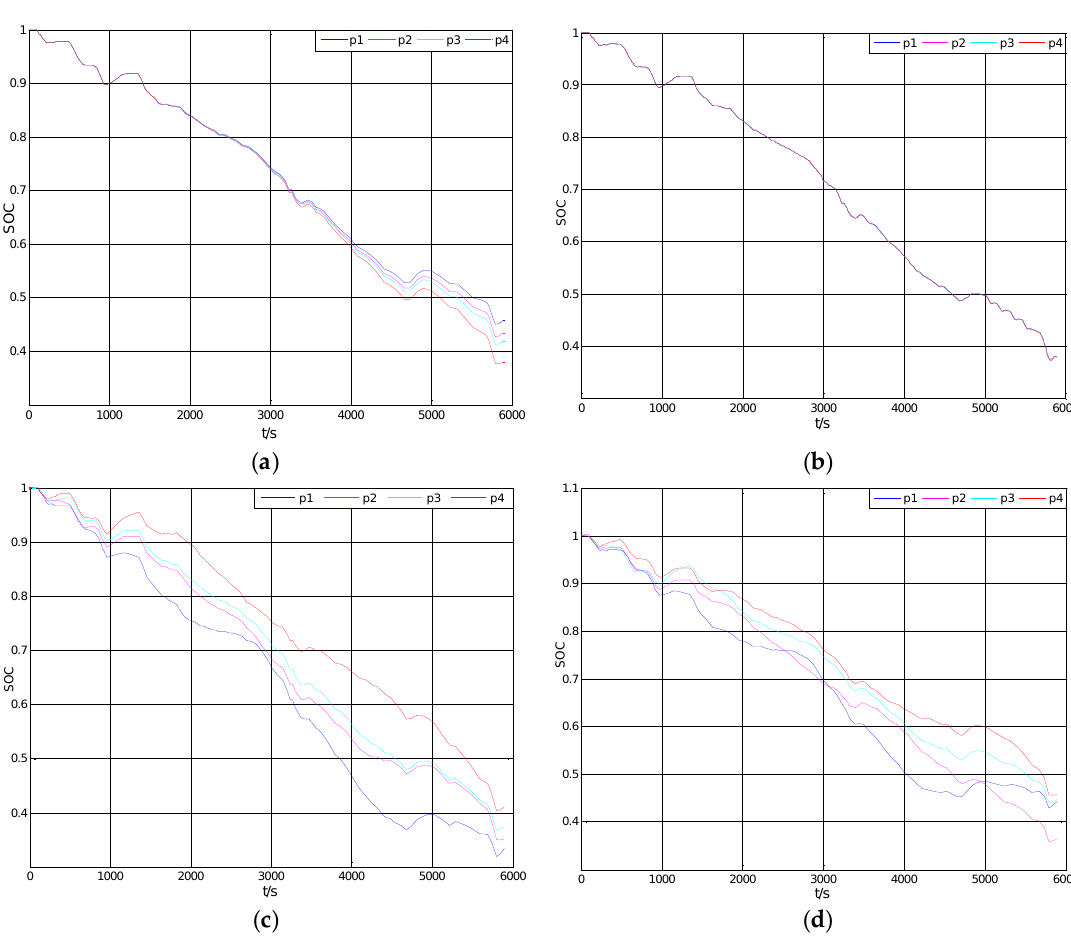
Figure 4. The results of state of charge (SOC) under different balancing control conditions. ( a ) Non-balancing control; ( b ) SOC balancing control; ( c ) Multi-objective balancing control; ( d ) Multi-objective predictive balancing control (MOPBC). Table 1. Simulation parameters.